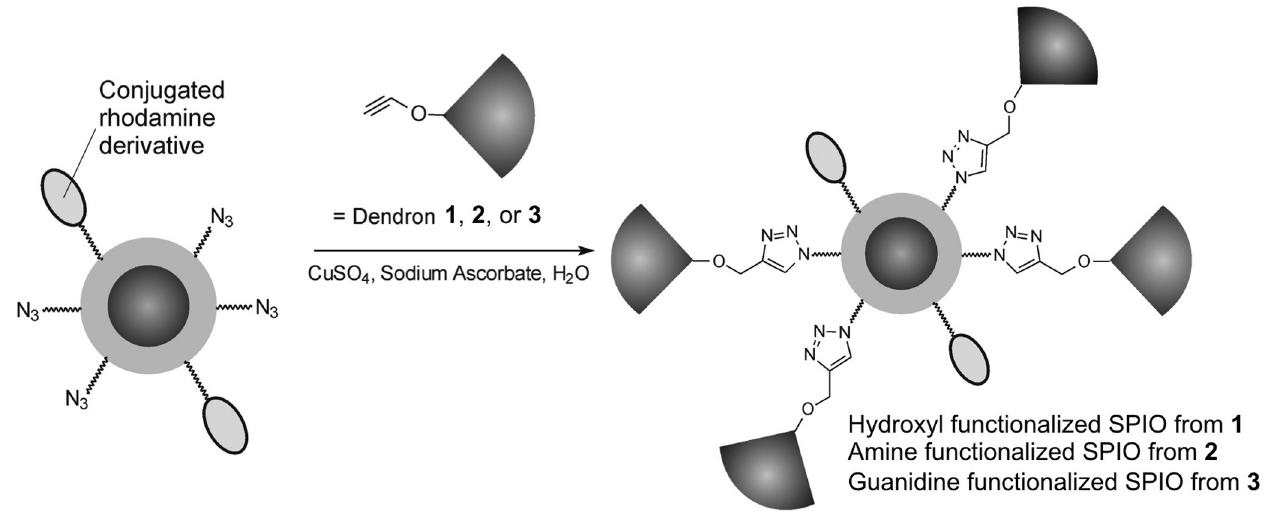
FIGURE 3 - “Click” conjugation of dendrons 1 , 2 , and 3 to azide functionalized SPIO to provide dendritic hydroxyl, amine, and guanidine functionalized SPIO respectively (Martin et al. , 2008).